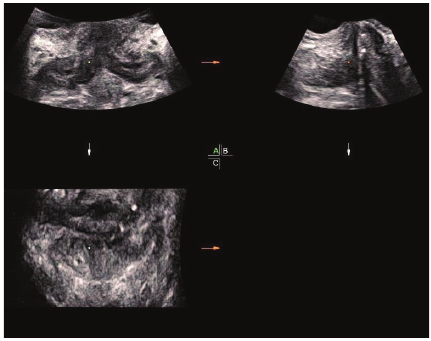
Figure 3: Postoperative 3D ultrasound